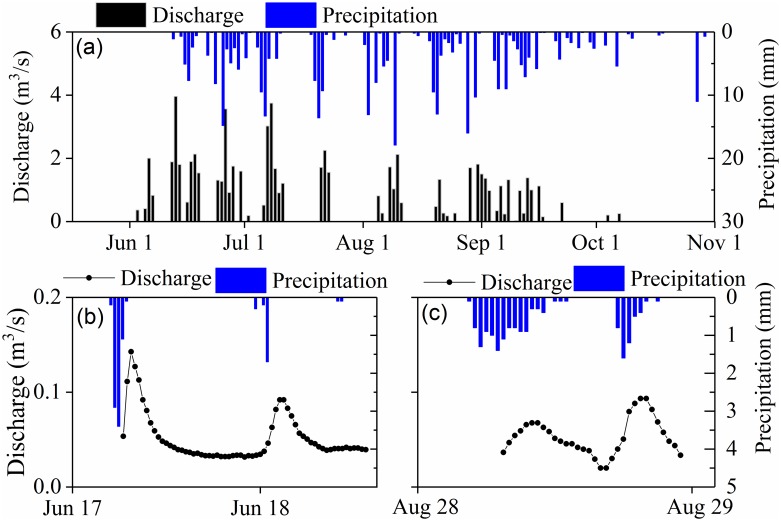
Time series of daily precipitation and streamflow (a), and precipitation and runoff events in 30 min intervals on (b) June 17 to 18 and (c) August 28.